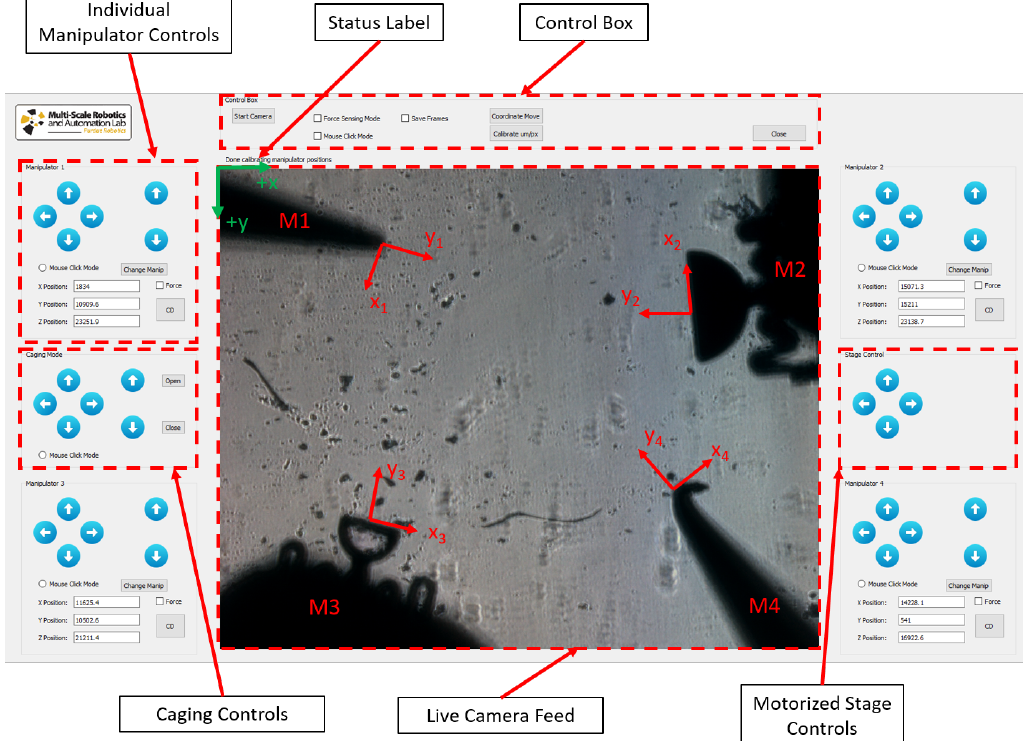
Figure 2. Workspace view and custom graphical user interface (GUI) for manipulator and stage control. In this case, a workspace configuration with two blunt probes (M1 and M4) and two force sensing probes (M2 and M3) is shown. The local coordinate frames for each manipulator (x i , y i ) are shown on their respective end-effectors. The global camera frame coordinate system is shown in the top-left corner